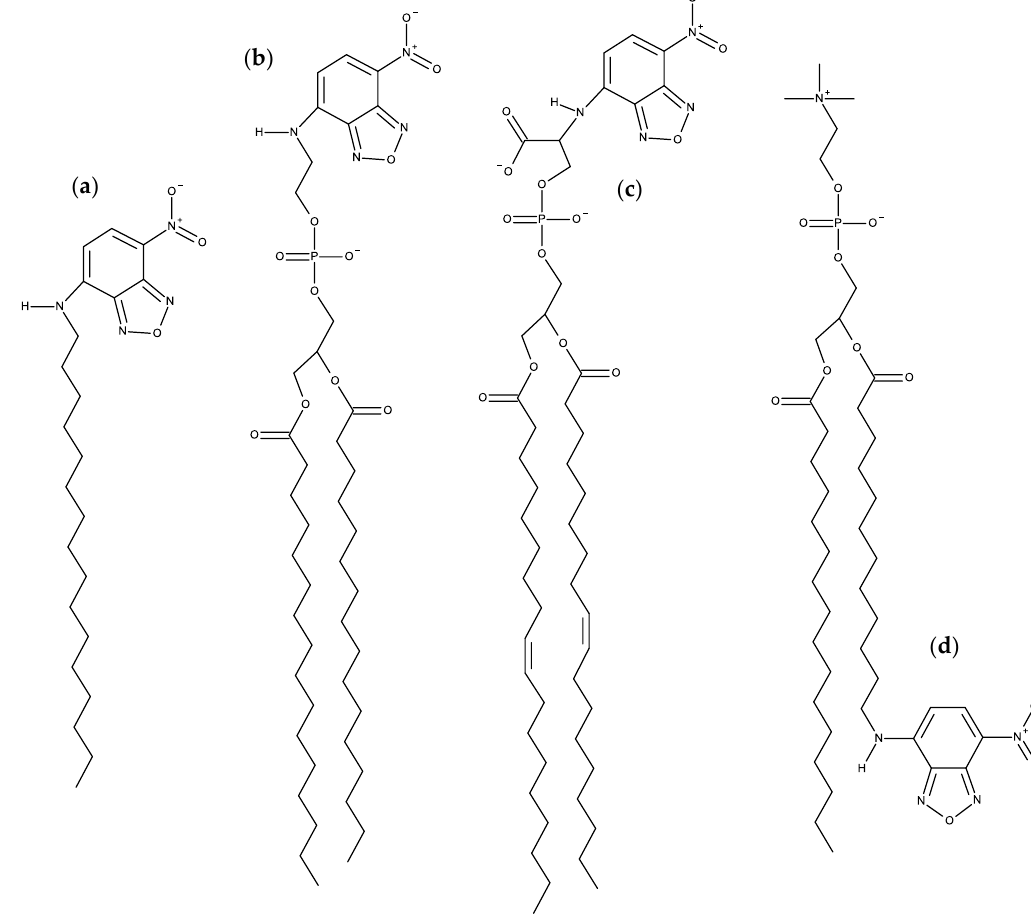
Figure 3. Structures of NBD probes. ( a ) NBD-C 16 ; ( b ) N -NBD-DPPE; ( c ) N -NBD-DOPS; ( d ) C 12 NBD-PC.